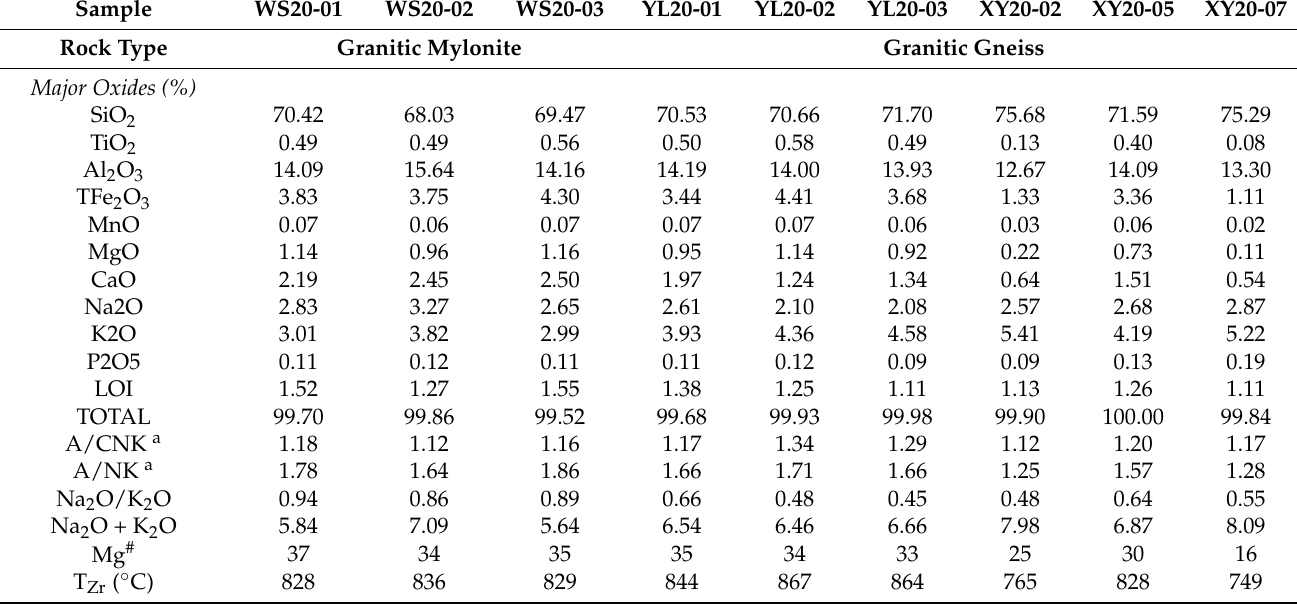
Table 2. Whole-rock major and trace element data for the early Neoproterozoic granitic rocks in the western margin of the NQT. a A/CNK = Al 2 O 3 /(CaO + Na 2 O + K 2 O) molar